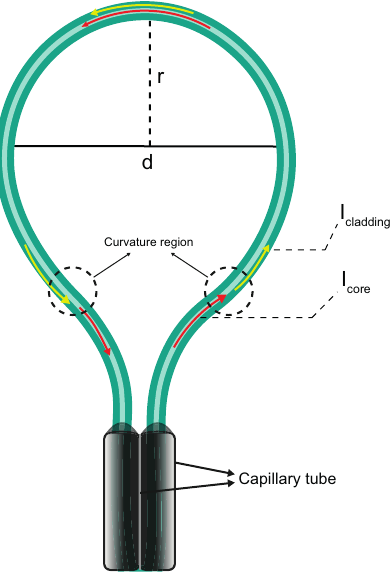
Figure 1. Schematic of the proposed balloon-like